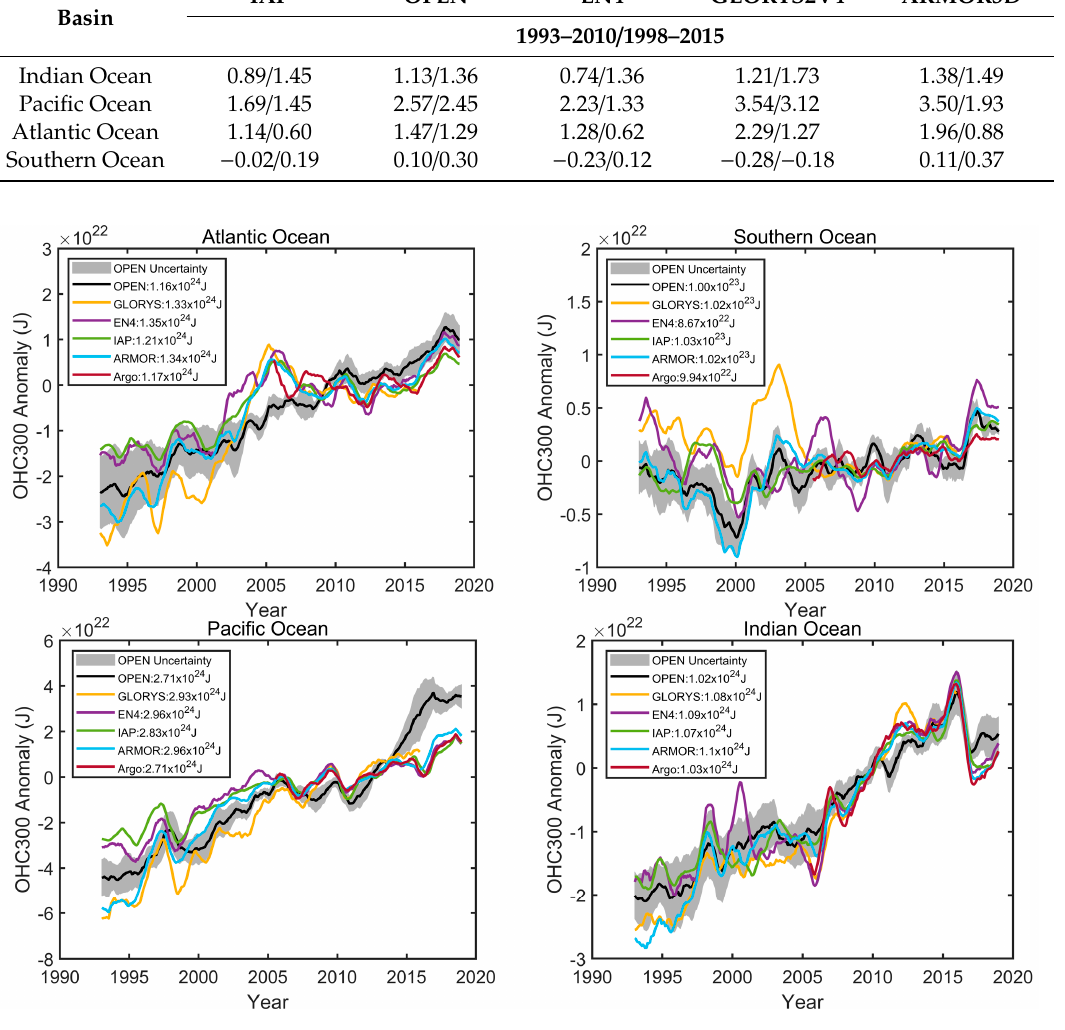
Figure 5. Same as Figure 4 but for four major ocean basins. The values in the legends indicate the reference, which is the average from 2005 to 2015 for each product. Notice that this reference is different from those in Figure 4 since the Argo data has a shorter time range.